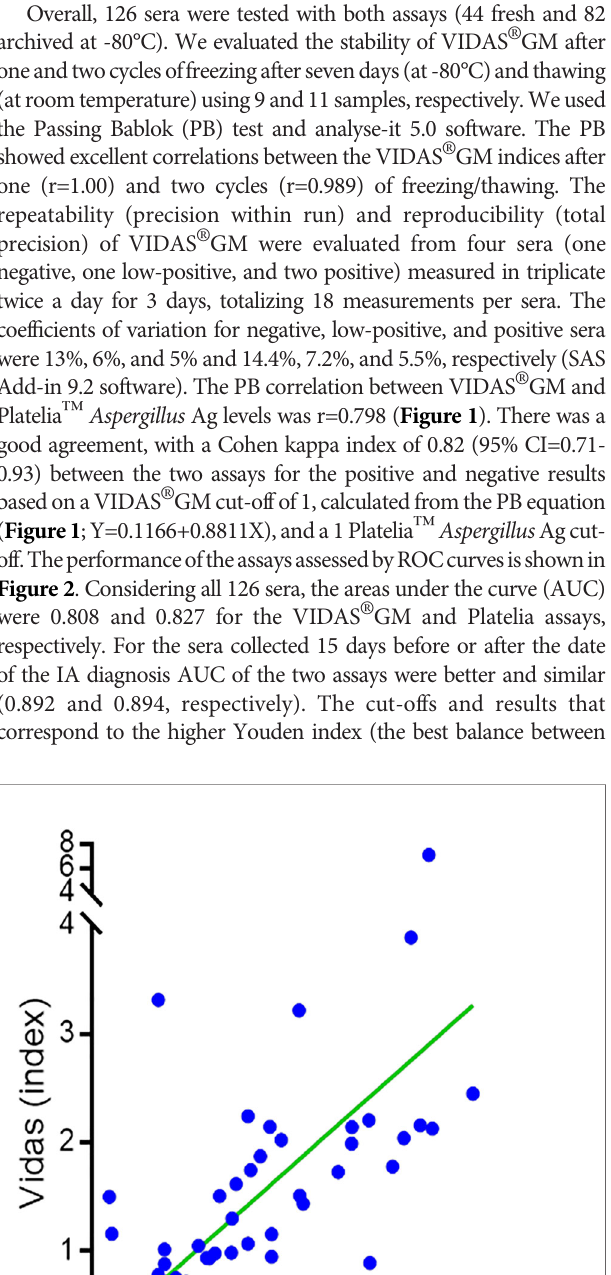
FIGURE 1 | Correlation between VIDAS ® GM and Platelia ™ Aspergillus Ag using serum samples. N = 118 (42 fresh and 76 frozen, samples with Platelia results ≥ 3.5 were